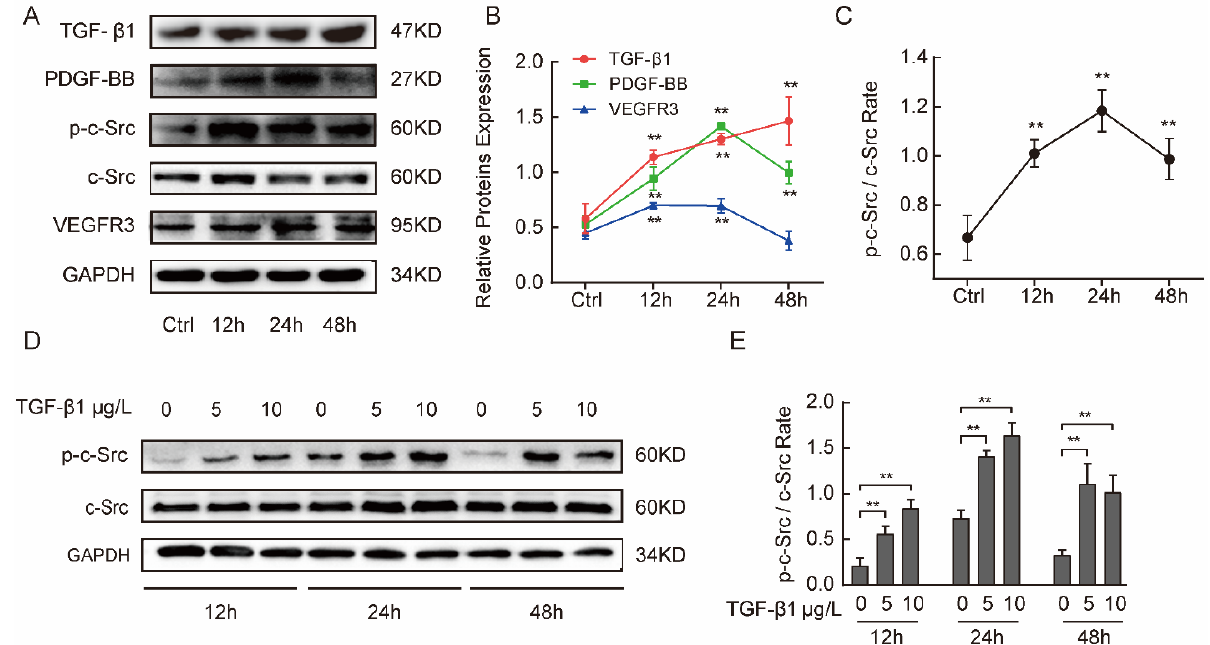
Figure 3. Silica suspension induced an increase of TGF- β 1 and TGF- β 1 promoted phosphorylation of c-Src protein in vitro. ( A – C ) The expression of TGF- β 1, PDGF, VEGFR3, and p-c-Src/c-Src at different treatment times of 50 mg/L silica suspension in MLE-12 cells. TGF- β 1 revealed an apparent increase in a time-dependent manner and PDGF, VEGFR3, and p-Src peaked at 24 h by when stimulated by a 50 mg/L silica suspension. ( D , E ) The expression p-Src and total c-Src at different TGF- β1 concentrations and treatment times. p -c-Src/c-Src had significant upregulation under 5 µg/L TGF- β1 treatment after 48 h or 10 µg/L TGF- β1 treatment after 24 h in MLE-12 cells with Western blotting. One-way analysis of variance. ** p < 0.01 versus control group in silica stimulated groups. ** p < 0.01 versus control group in TGF- β1 treated groups. The results are shown as mean ± SD from triplicate experiments.